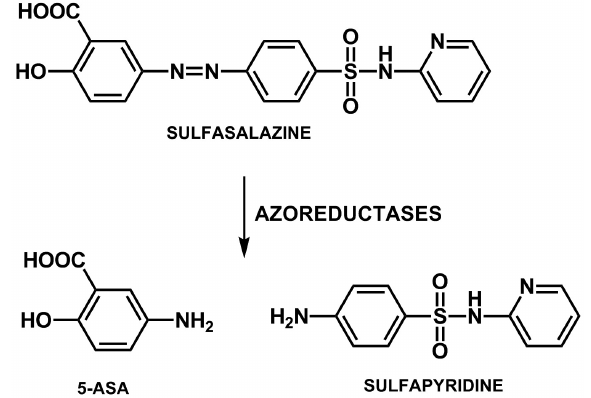
FIGURE 31 - Diagram of the bioactivation of sulfasalazine through the action of